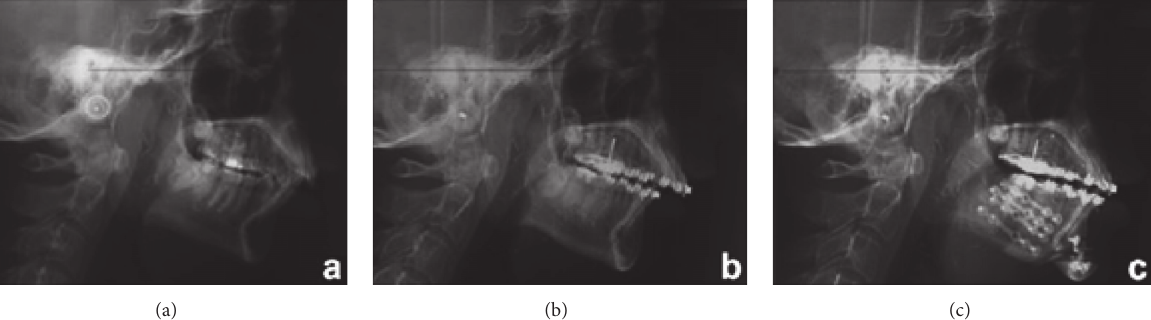
Figure 8: Teleradiography in lateral projection before orthodontic treatment (a), at the end of presurgical orthodontics (b), and after orthognathic surgery (c).